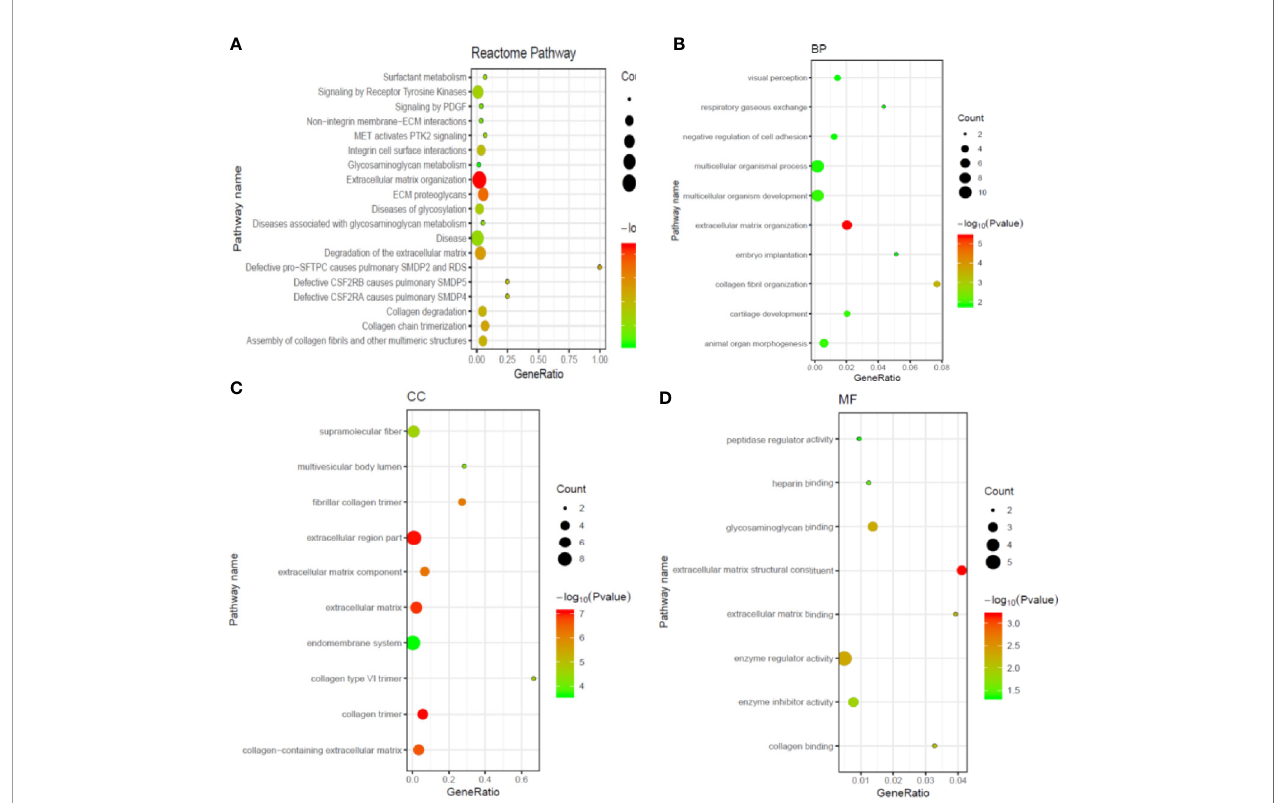
FIGURE 2 | Gene ontology (GO) and Kyoto Encyclopedia of Genes and Genome (KEGG) enrichment analysis for functions of differentially expressed genes in metastatic ccRCC. (A) The top 20 most signi fi cant KEGG pathway terms; (B) The top 10 most signi fi cant changes in the GO biological process; (C) The top 10 most signi fi cant changes in the GO cellular component; (D) The top 10 most signi fi cant changes in the GO molecular